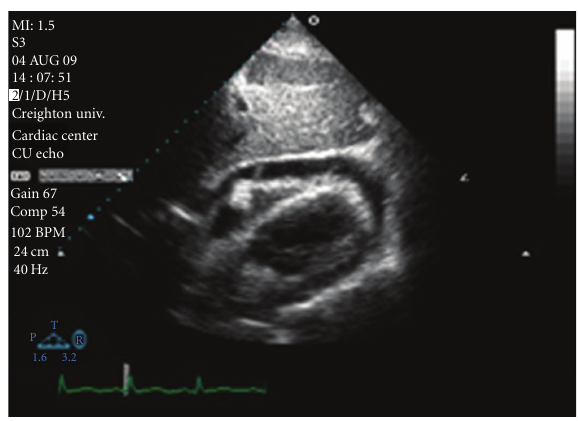
Figure 1: Subcostal view of hemorrhagic pericardial e ff usion. (There isa collapse of the right ventricular free wallduring